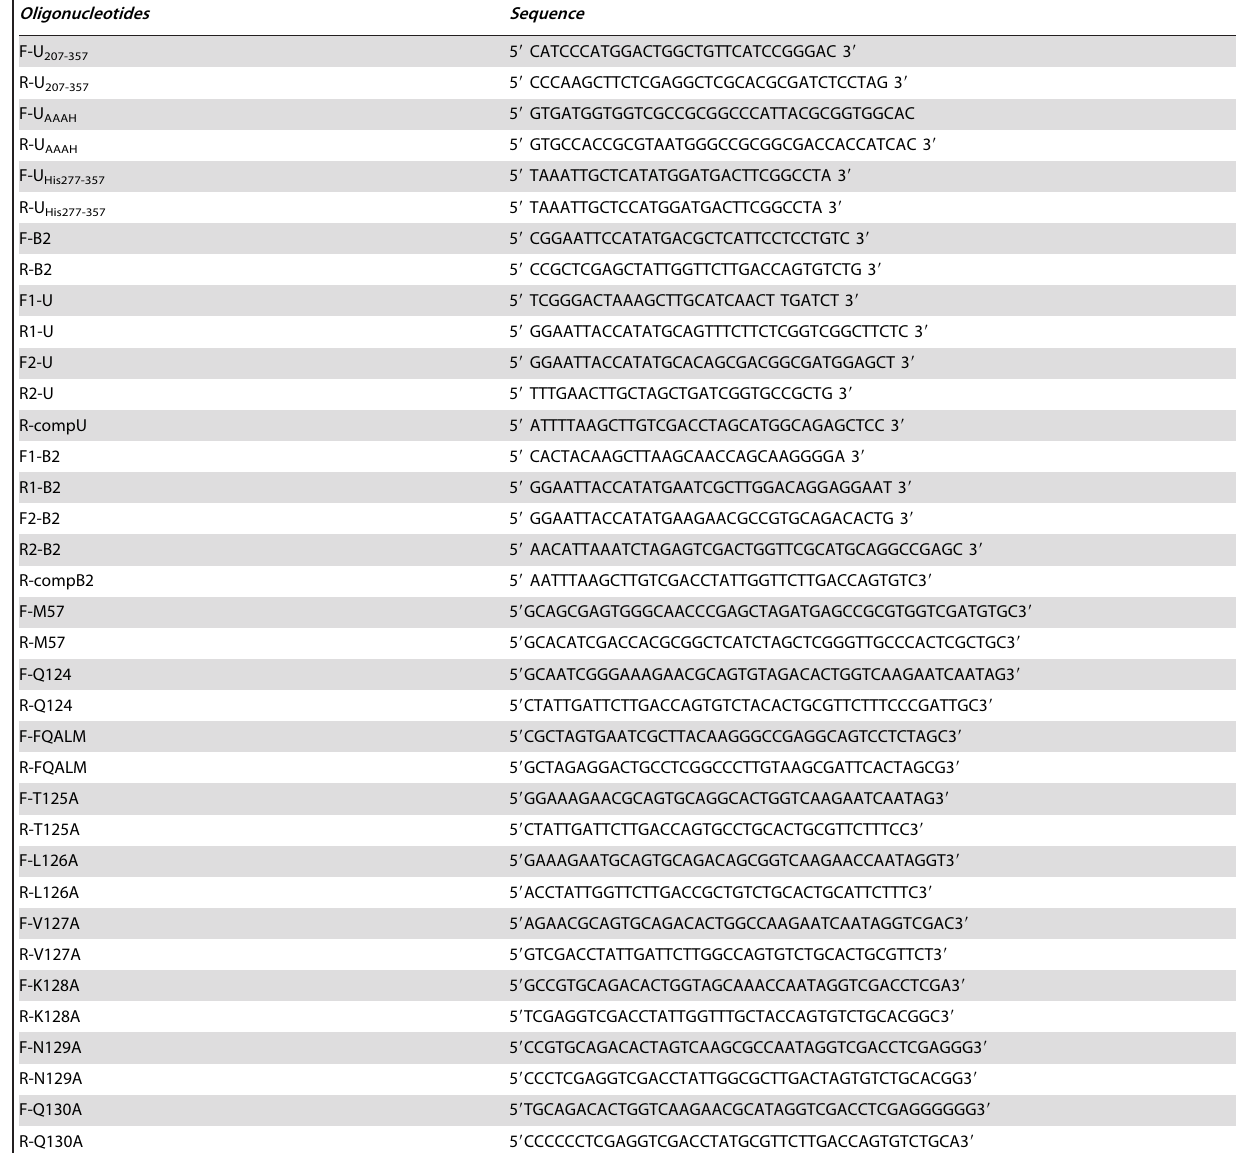
Oligonucleotides